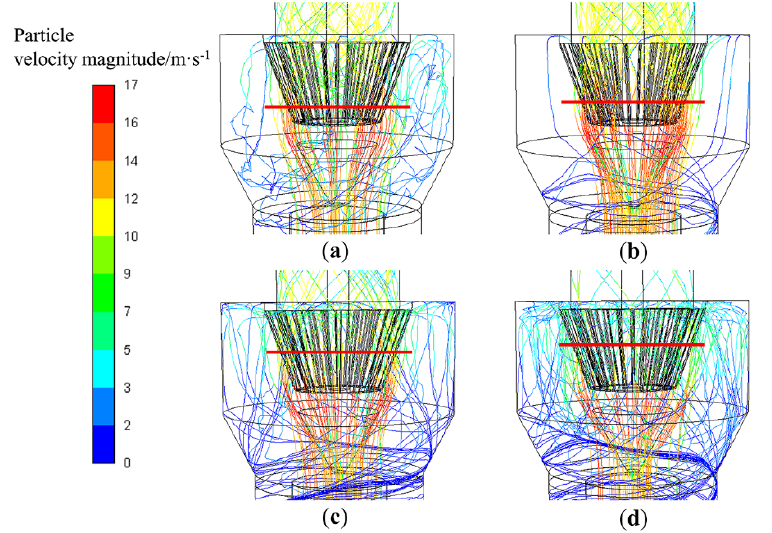
Figure 12. Trajectories of different size particles in T-E (1-0.6) : ( a ) d = 5 μ m, ( b ) d = 15 μ m, ( c ) d = 25 μ m, and ( d ) d = 35 μ m.